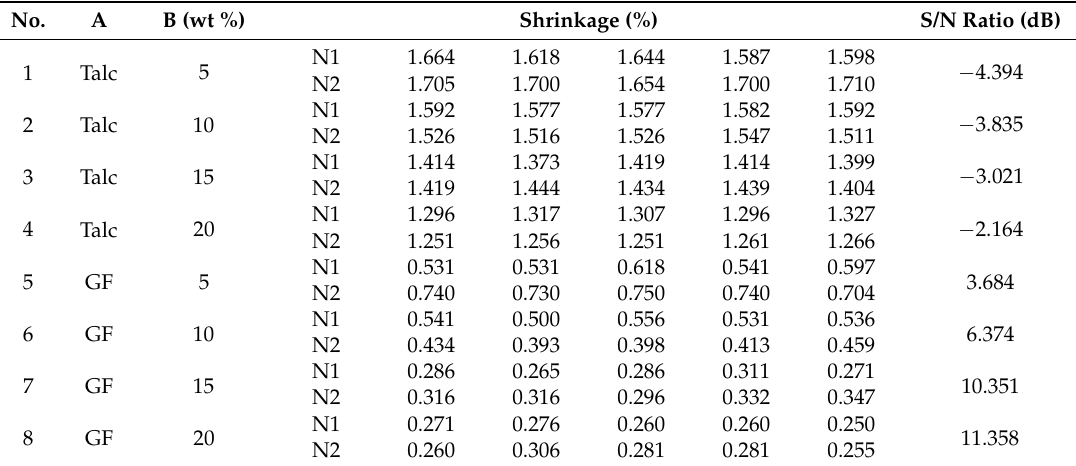
Table 9. Signal-to-noise (S/N) ratio of shrinkage in the flow direction.